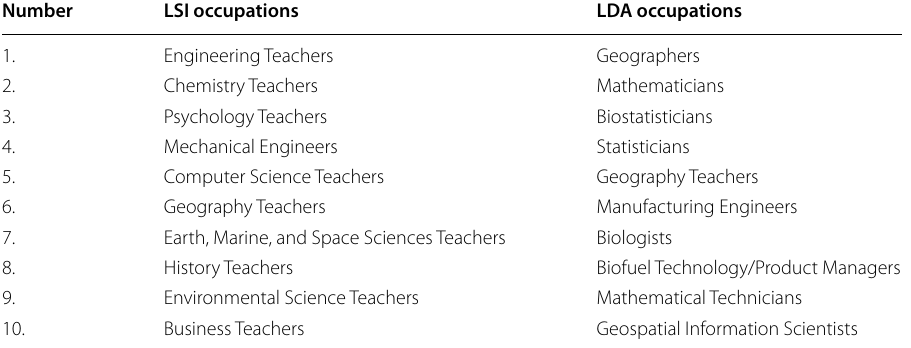
Table 5 Top 10 UAE oil & gas occupations from LSI (left) and LDA (right) academic data Number LSI